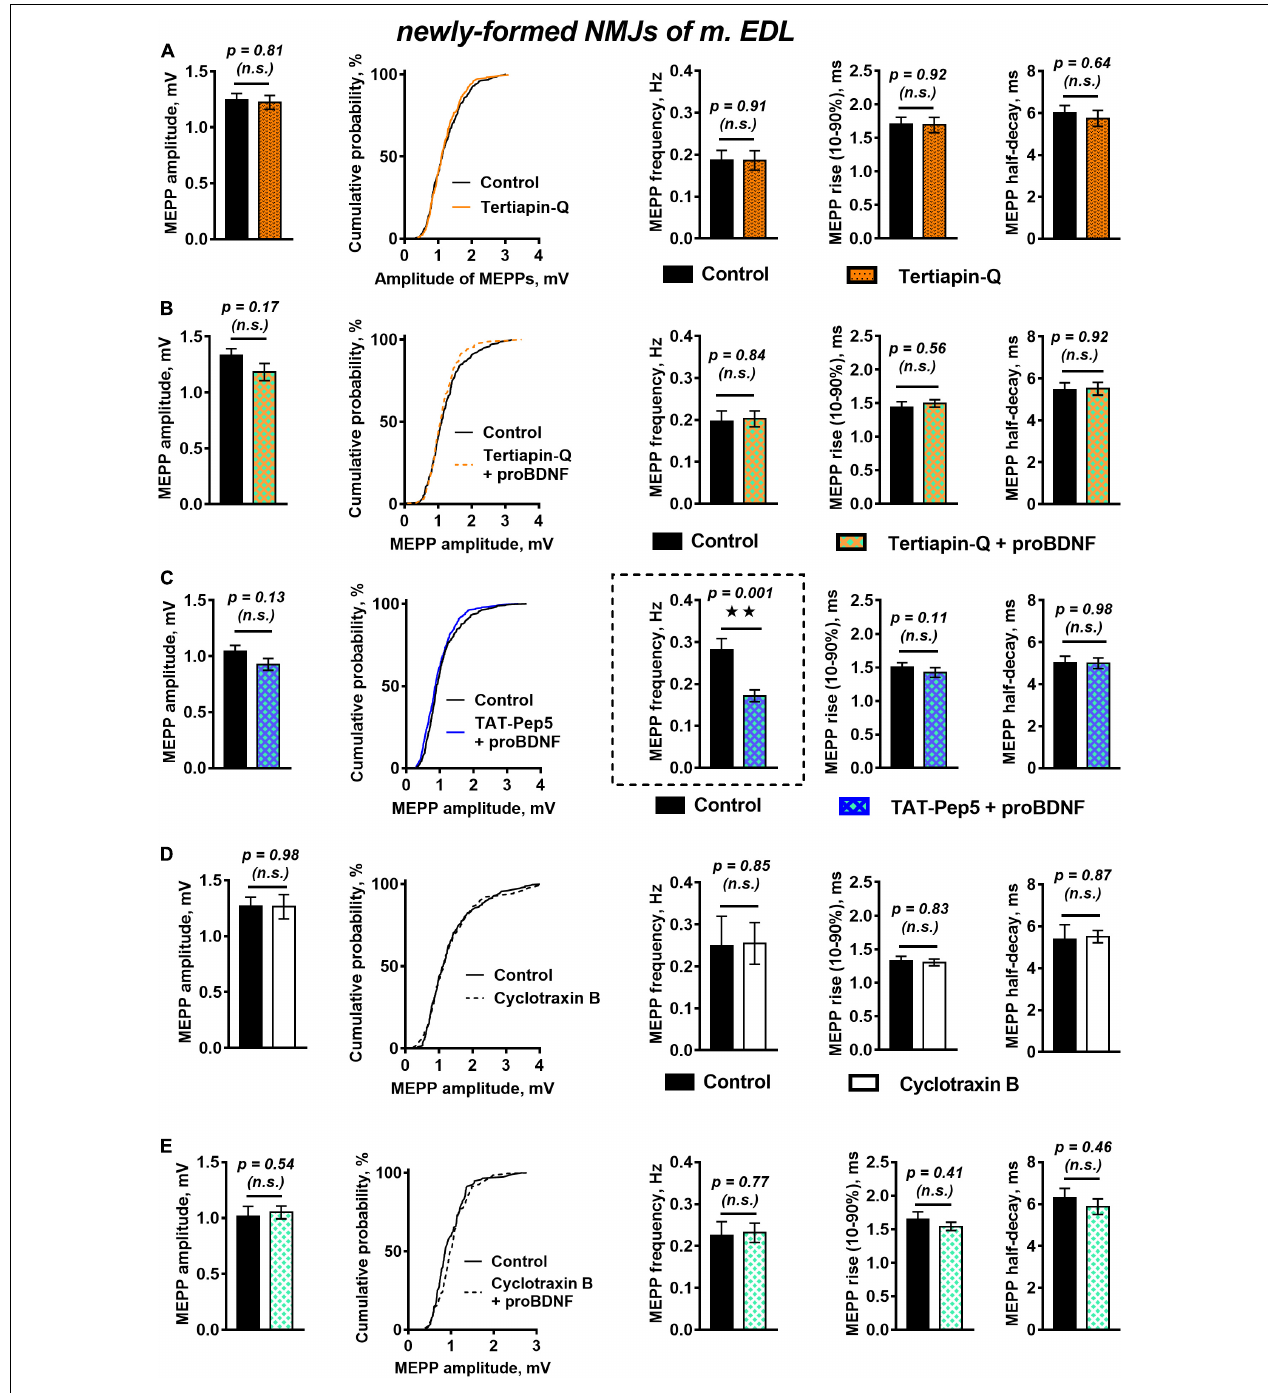
FIGURE 2 | Inhibition of GIRK channels and TrkB receptors but not Rho-GDI-associated signaling of p75 receptors, abolish proBDNF-induced decrease in MEPP frequency newly formed NMJs. (A) Mean MEPP amplitude, cumulative probability plots, frequency, and time-course parameters (left to right) in control ( n = 21) and upon application of GIRK blocker tertiapin-Q (100 nM, n = 23). (B) Mean MEPP amplitude, cumulative probability plots, frequency, and time-course parameters (left to right) in control ( n = 17) and upon application of proBDNF (1 nM) in the presence of tertiapin-Q (100 nM, n = 26). (C) Mean MEPP amplitude, cumulative probability plots, frequency, and time-course parameters (left to right) in control ( n = 23) and upon application of proBDNF (1 nM) in the presence of Rho-GDI-associated p75 signaling inhibitor TAT-Pep5 (1 µ M, n = 31). (D) Mean MEPP amplitude, cumulative probability plots, frequency, and time-course parameters (left to right) in control ( n = 15) and upon application of TrkB antagonist cyclotraxin B (100 nM, n = 19). (E) Mean MEPP amplitude, cumulative probability plots, frequency, and time-course parameters (left to right) in control ( n = 19) and upon application of proBDNF (1 nM) in the presence of cyclotraxin B (100 nM, n = 28).